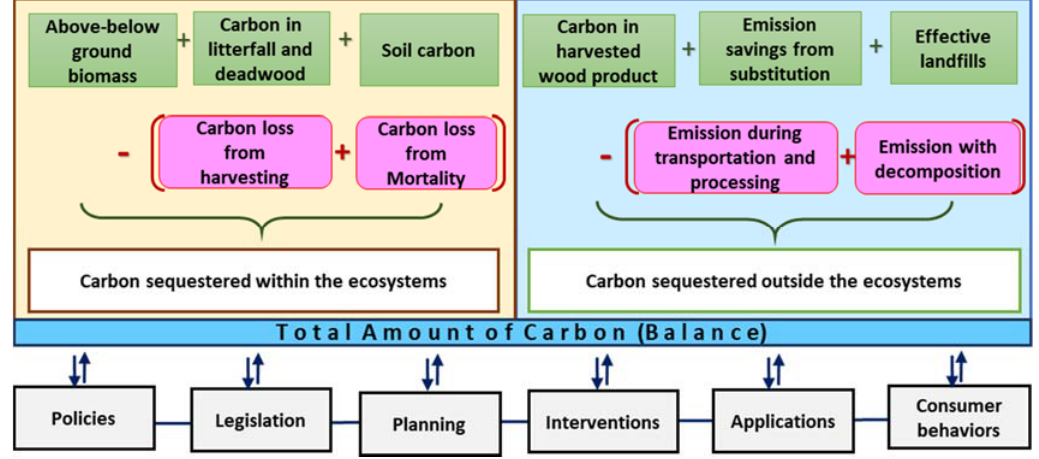
Figure 2. Illustration of carbon balance based on gains and loss as well as outside factors.